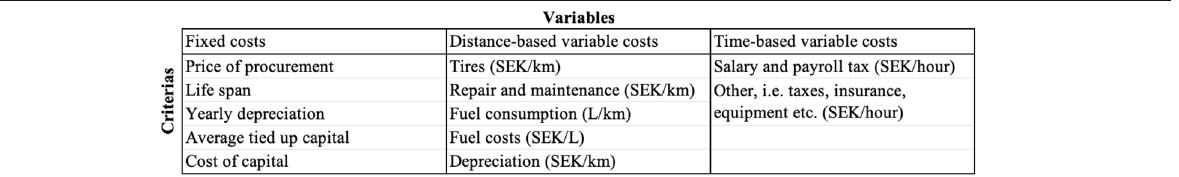
Table 2 Variables comprehended in the suggested Cost Benefit